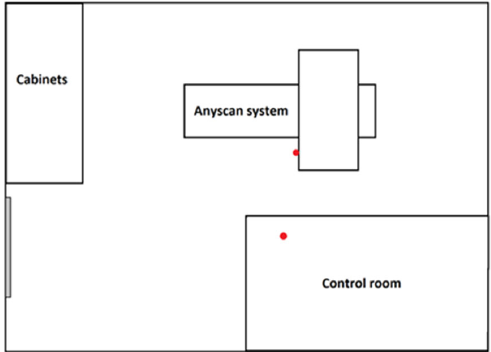
Figure 2. Schematic drawing of Mediso Anyscan acquisition room with detectors’ locations (red circles).